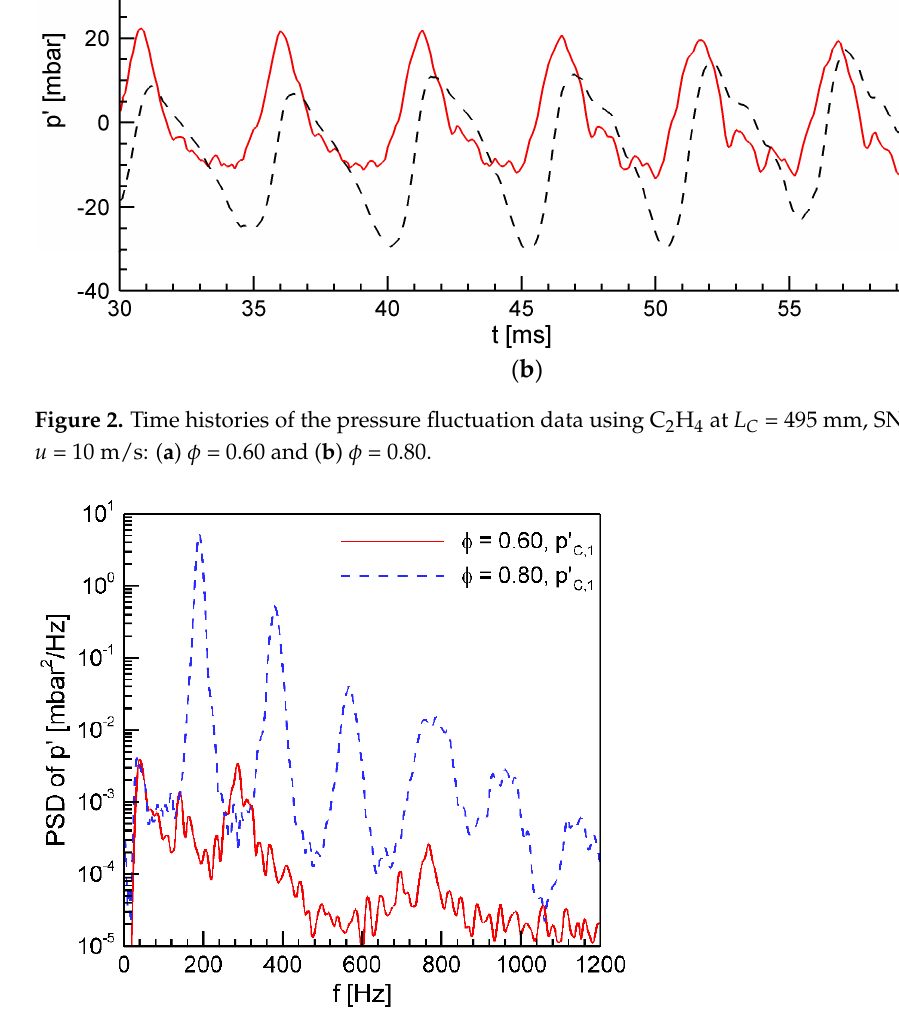
Figure 2. Time histories of the pressure fluctuation data using C 2 H 4 at L C = 495 mm, SN = 0.80, and u = 10 m/s: ( a ) ϕ = 0.60 and ( b ) ϕ = 0.80.